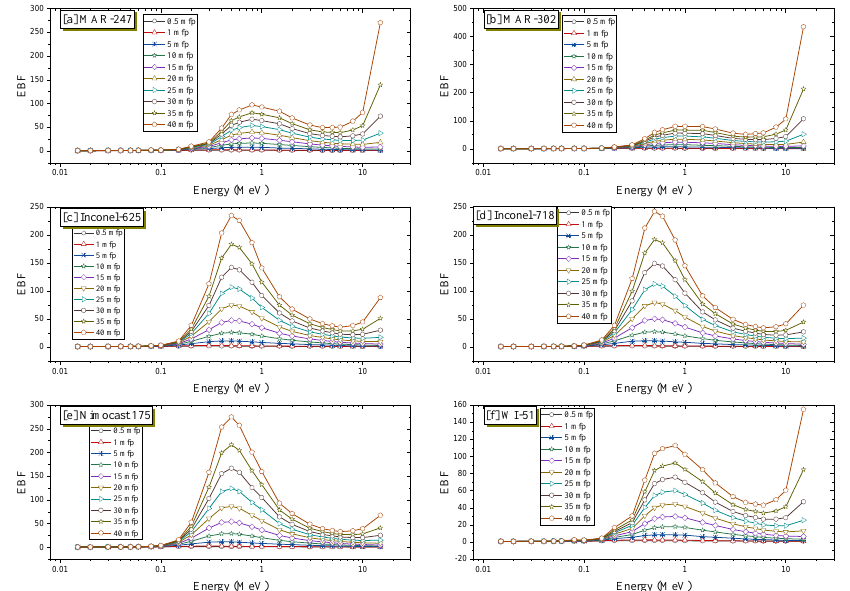
Figure 7. Variation of the exposure buildup factor (EBF) versus the incident gamma-ray energy at various penetration depths for the investigated alloys: ( a ) MAR-247, ( b ) MAR-302, ( c ) Inconel-625, ( d ) Inconel-718, ( e ) Nimocast-75, ( f ) WI-51. The variation of buildup factors with the penetration depth (PD) for the selected alloys is presented in Figure 8 at some fixed gamma-ray energies (0.015, 1, and 15 MeV). At around 0.015 MeV, for all the selected alloys, the values slowly increased with the increase in the PD. At 1 MeV, where CS is prevalent, EBF and EABF steadily increased with the increase in PD, especially at high PD (≥20 mfp). Additionally, at high energies, the values quickly increased with the penetration depth, especially for PD ≥20.